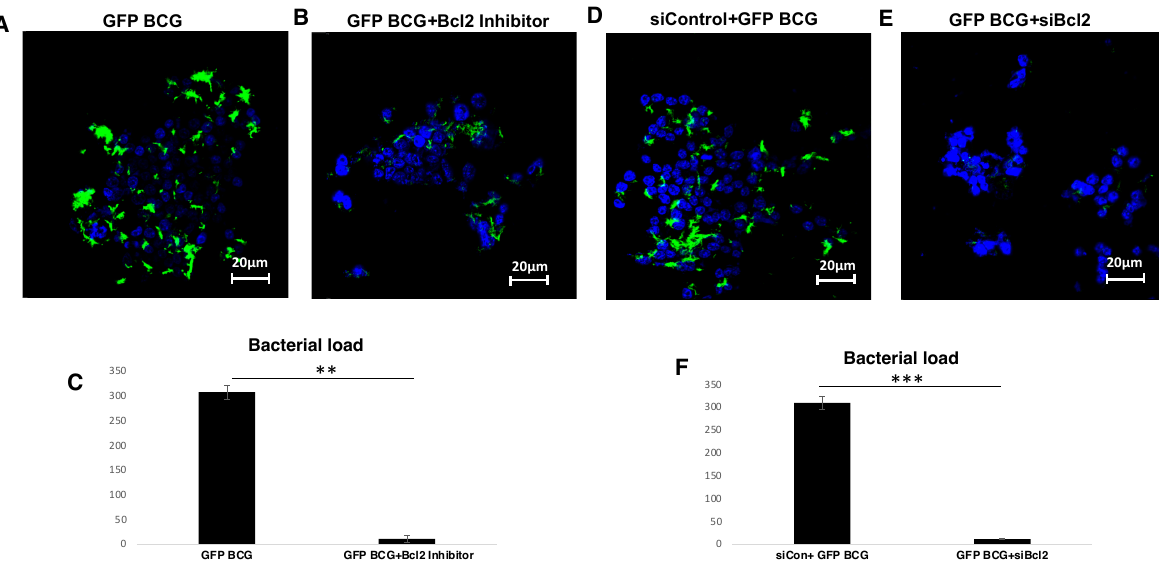
Figure 10: T cells activated by Bcl2 deficient BMDCs reduce bacterial burden in macrophages. BMDCs were treated or not with 10 μM Bcl2 Inhibitor (Panel B) or siBcl2 (Panel E) prior to infection with 2.5 MOI BCG for 24h. These BMDCs were co-cultured for 48h with BCG immunized T cells. T cells were then enriched from the BMDC:T cell co-culture by MACS and incubated with 10 MOI GFP-BCG infected J774 murine macrophages for 72h. Bacterial burden was monitored by confocal microscopy. Data shows a representative image of three experiments. Bar charts in Panel C&F represent the Mean Fluorescence Intensities (MFI) for two independent experiments (of 5 fields/ experiment). Data represents Mean ± SD of two independent experiments. For Panel C, P value between groups GFP BCG and GFP BCG+Bcl2 Inhibitor. For Panel F, P value between groups si Control+GFP BCG and GFP BCG+siBcl2 is P <0.001. Student’s t-test was performed. ** denotes statistical significance at P< 0.01, *** denotes statistical significance at